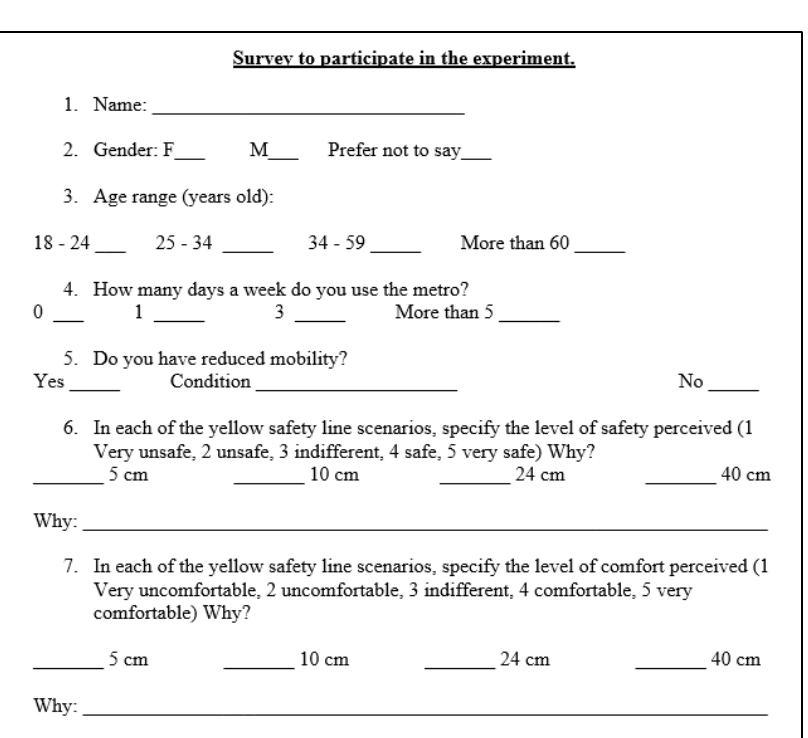
Figure 4. Survey questionnaire given to each of the volunteers who participated in the in each yel- low-safety-line scenario. yellow-safety-line